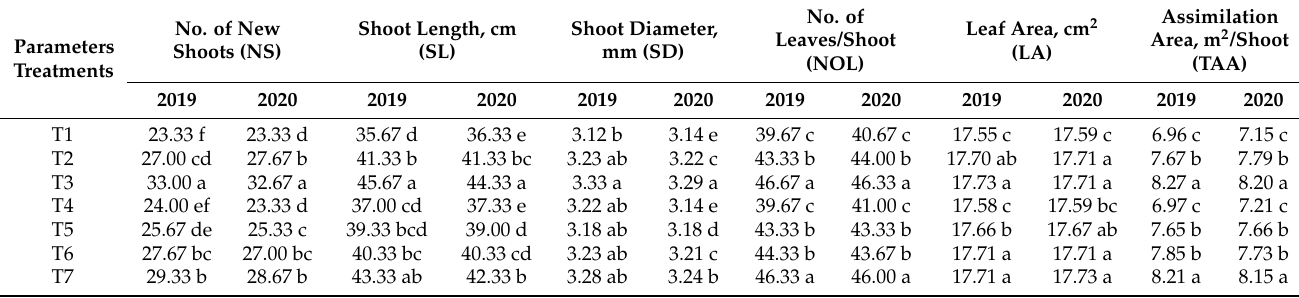
Means followed by the same letter/s within each column did not significantly differ at 5% level. T1, T2, T3, T4, T5, T6, and T7 are control, Fe-NPs 1, Fe-NPs 2, FeSO 4 (0.1%), FeSO 4 (0.2%), Fe-chelated (0.05%), and Fe-chelated (0.1%), respectively. Table 2. Influence of iron (nano, sulfate, and chelated) foliar spray on chlorophyll (A), chlorophyll (B), carotenoids, and total chlorophyll of Washington navel orange trees during 2019 and 2020 experimental seasons. Chlorophyll A, Chlorophyll B, Total Chlorophyll, Carotenoids, mg/g-1F.W. mg/g-1F.W. mg/g-1F.W. mg/g-1F.W. Parameters (CA) (CB) (TC) Treatments